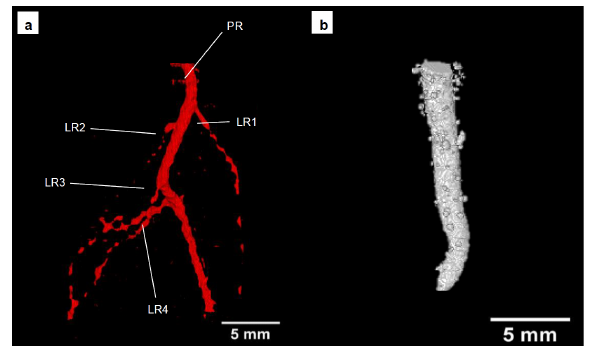
Figure 2. Schematic of laminar cylinder used as region of inter- est to estimate the local void